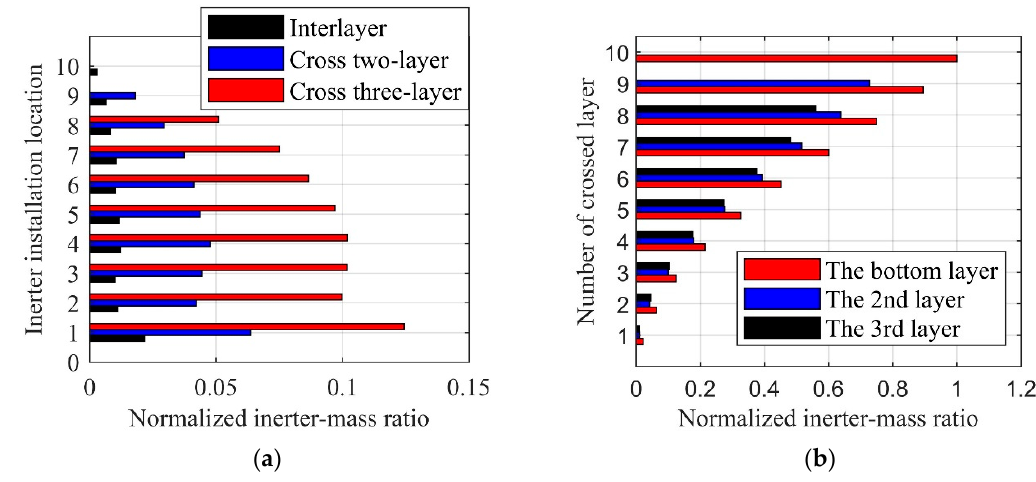
Figure 8. Illustration of the modal inerter-mass ratios: ( a ) the influence of installation location; ( b ) the